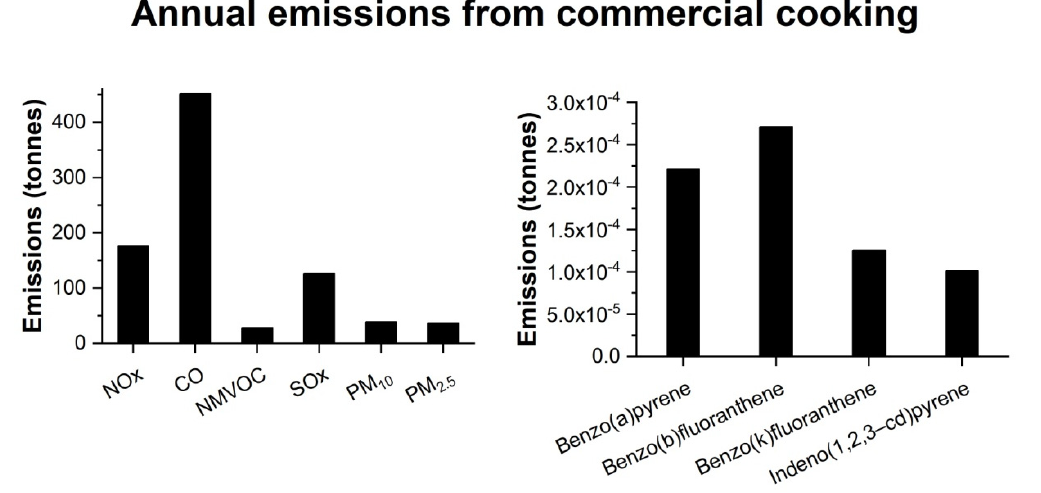
Figure 5. Emissions from the fuel combustion during commercial cooking activities in the Greater Athens area.